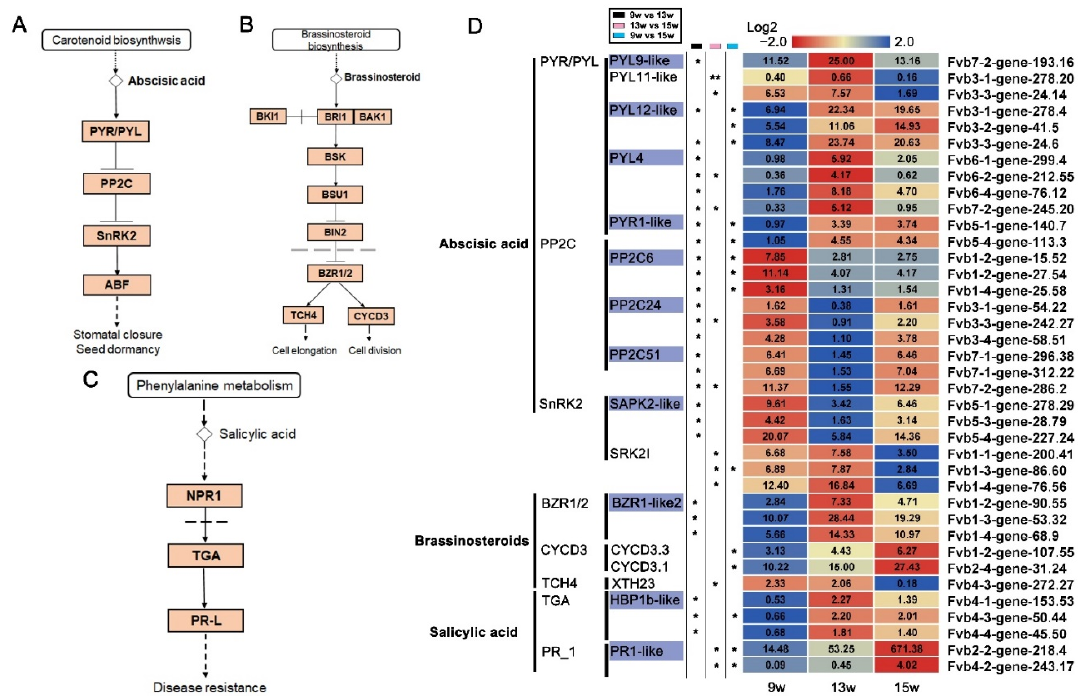
Figure 9. DEGs involved in abscisic acid, brassinosteroid, and salicylic acid signaling pathways. ( A – C ) Abscisic acid, brassinosteroid, and salicylic acid signal transduction pathways by referring to the KO04075 pathway in KEGG enrichment analysis. ( D ) Heatmaps showing the relative expression of DEGs involved in the above-mentioned hormone signaling pathways. The purple boxes indicate the genes in which expression was significantly changed by 9 w vs. 13 w. 9 w: vegetative stage, 13 w: shifts to the reproductive stage at the gene level, 15 w: reproductive stage. The column with the black boxes represents the student’s t test analysis of DEGs by 9 w vs. 13 w; The column with the pink boxes represents the student’s t test analysis of DEGs by 13 w vs. 15 w; The column with the blue boxes represents the student’s t test analysis of DEGs by 9 w vs. 15 w. (* |Log2FC| ≥ 1, p < 0.05. ** |Log2FC| ≥ 2, p < 0.01).